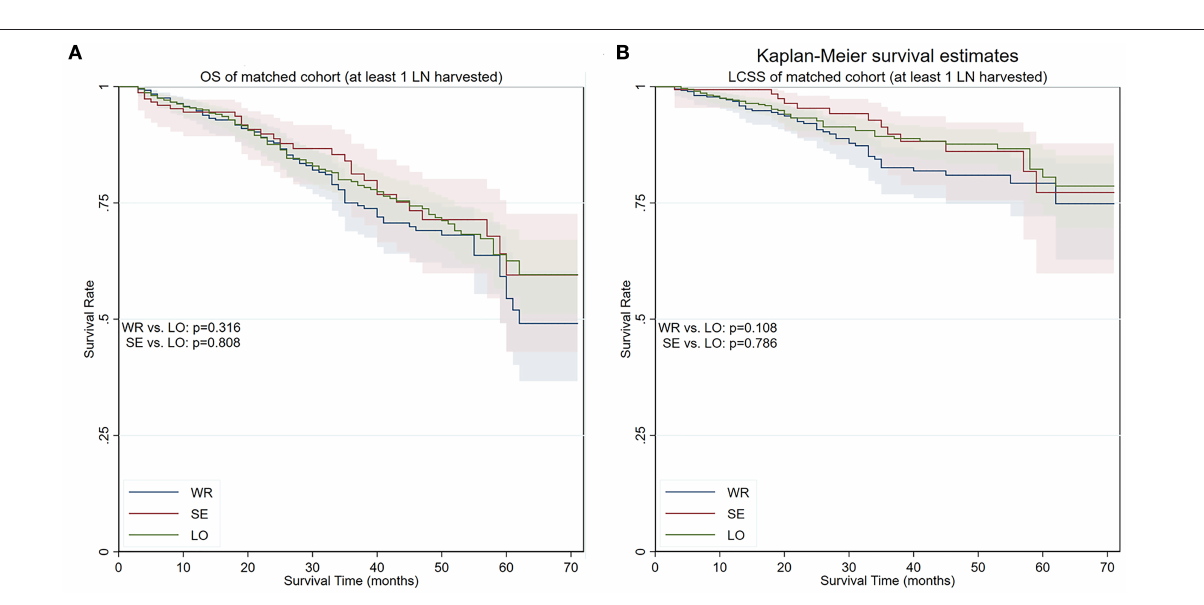
the OS and LCSS differences diminished in the propensity score– matched group when at least one lymph node was examined, and the said correlation did not cease to exist until the age exceeded